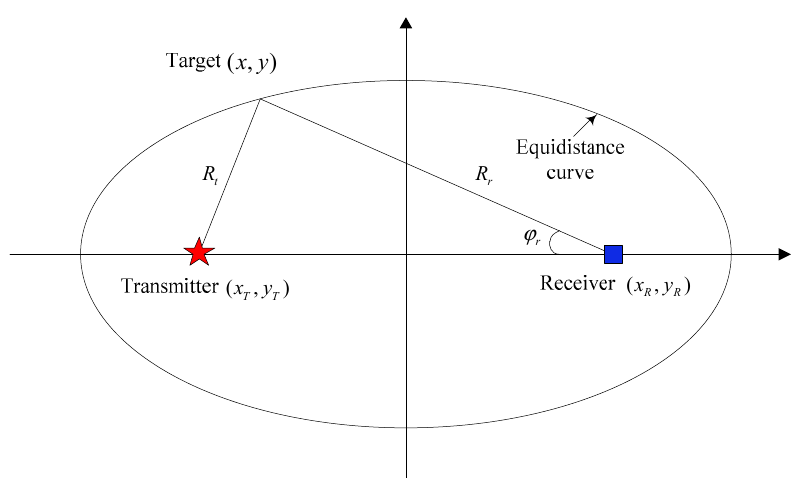
Figure 3. The geometry of a single transmitter-target-receiver pair. Locations of the transmitter and the receiver are shown with the red star and blue square, respectively. The equidistance curve can be plotted using the bistatic range ρ = R t + R r and the target position is further determined using the bearing ϕ r .